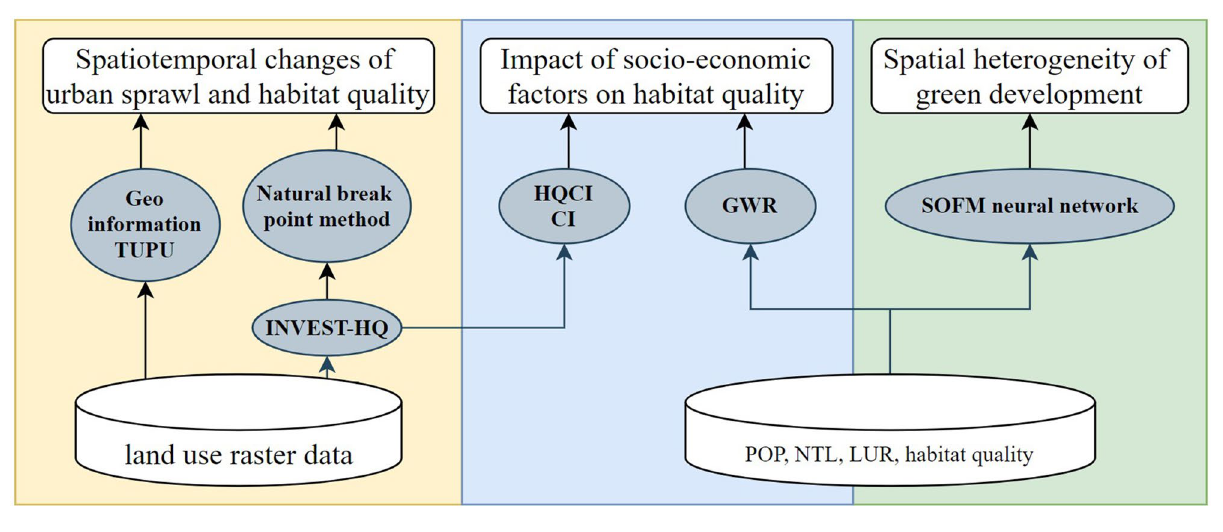
Figure 2. Research